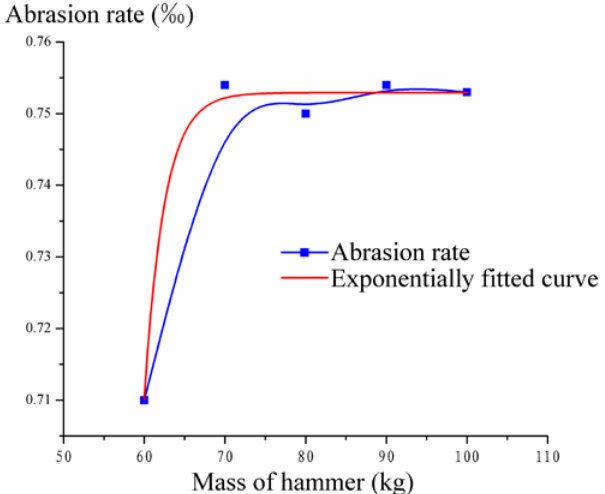
Figure 6: Variation of anvil mass on the abrasion property of hydraulic hammer with horizontal oriented sliders. Effects of Moving Velocity of the Anvil on Abrasion Property of Horizontal Oriented Sliders